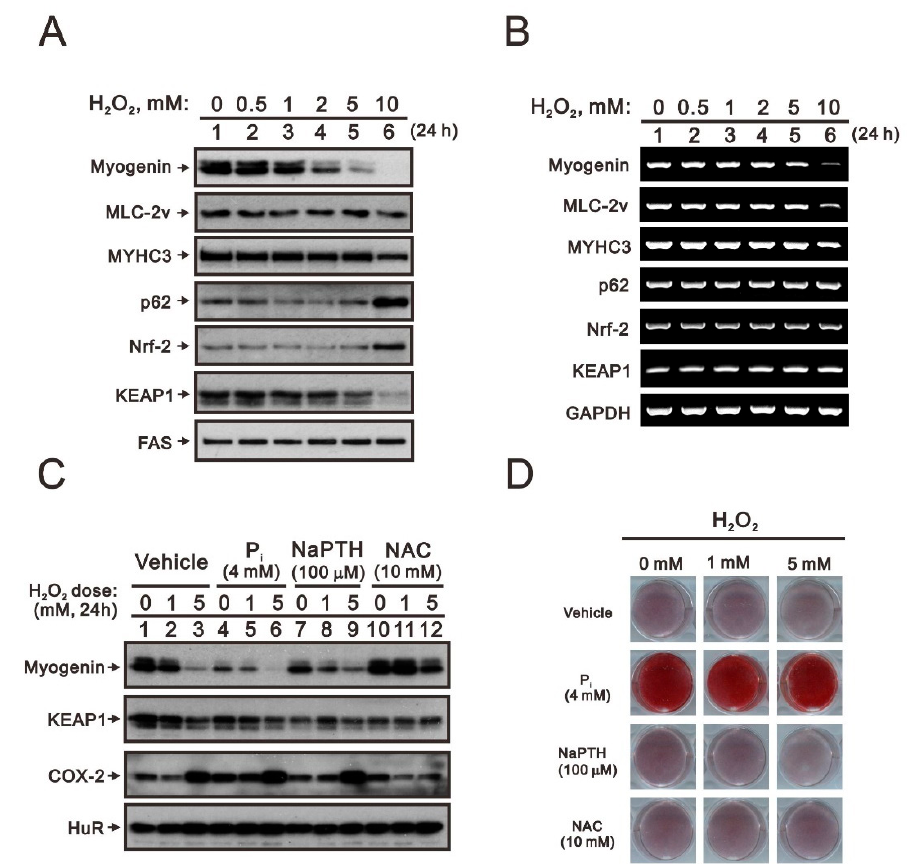
Figure 5. The effects of hydrogen peroxide on the Keap1/Nrf2/p62/myogenin pathway in differentiated C2C12 cells. ( A , B ) After induction of differentiation by culturing C2C12 cells in differentiation medium for 3 days, differentiated C2C12 cells were treated with the indicated concentration of hydrogen peroxide (H 2 O 2 ) for 24 h. Cell lysates were subject to immunoblot analysis against indicated proteins. ( A ) Cell lysates were subject to immunoblot analysis against myogenin, MLC-2v, MYHC3, p62, Nrf2, and Keap1 proteins. FAS was used as loading control. ( B ) Effects of doxorubicin on the mRNA expression of myogenin , MLC-2v , MYHC3 , p62 , Nrf2 , and Keap1 determined by RT-PCR. GAPDH was used as loading control. ( C , D ) Differentiated C2C12 cells were treated with the indicated concentration of hydrogen peroxide with 4 mM P i , 100 μ M NaPTH, or 10 mM NAC for 24 h. ( C ) Cell lysates were subject to immunoblot analysis against myogenin, Keap1, and Cox-2 proteins. HuR was a protein loading control. ( D ) Cells treated with indicated drugs were stained with Alizarin Red S dye.